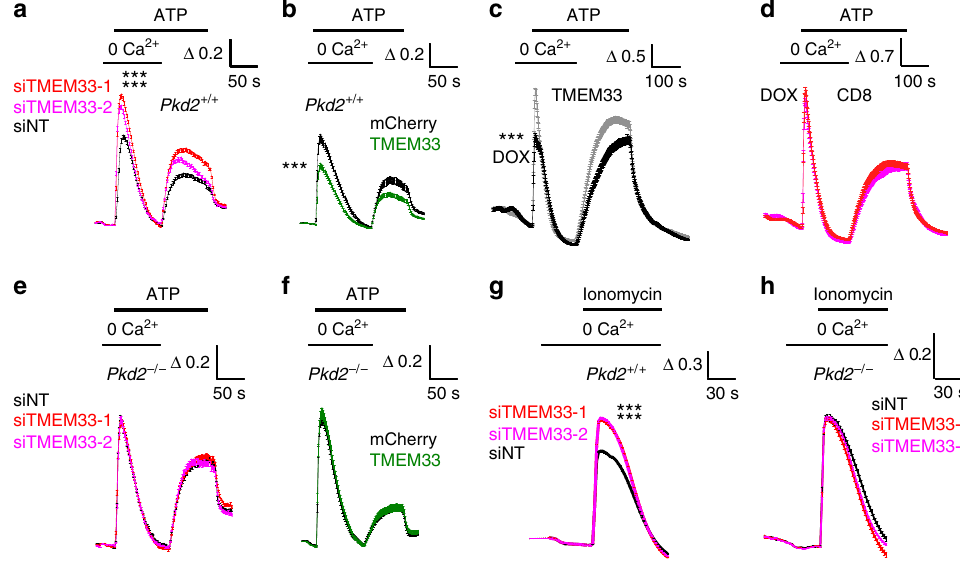
Fig. 2 TMEM33 regulates intracellular calcium homeostasis. a Increases in cytosolic calcium concentration are expressed as ratios of 340:380 nm fl uorescence signals ( Δ R/R Δ R is the fl uorescence ratio (340 nm/380 nm) measured at a given time divided by the initial ratio at time 0 (R 0 ). Transfection of PCT cells with two siRNAs directed against TMEM33 increases ATP calcium transients recorded in the absence of extracellular calcium, as compared to the control non-targeting siRNA condition (siNT, n = 684, black symbols; siTMEM33 – 1, n = 589, red symbols; siTMEM33 – 2, n = 649, magenta symbols). Re-addition of extracellular calcium during the ATP stimulation elicits a capacitative calcium entry. b Same in PCT cells